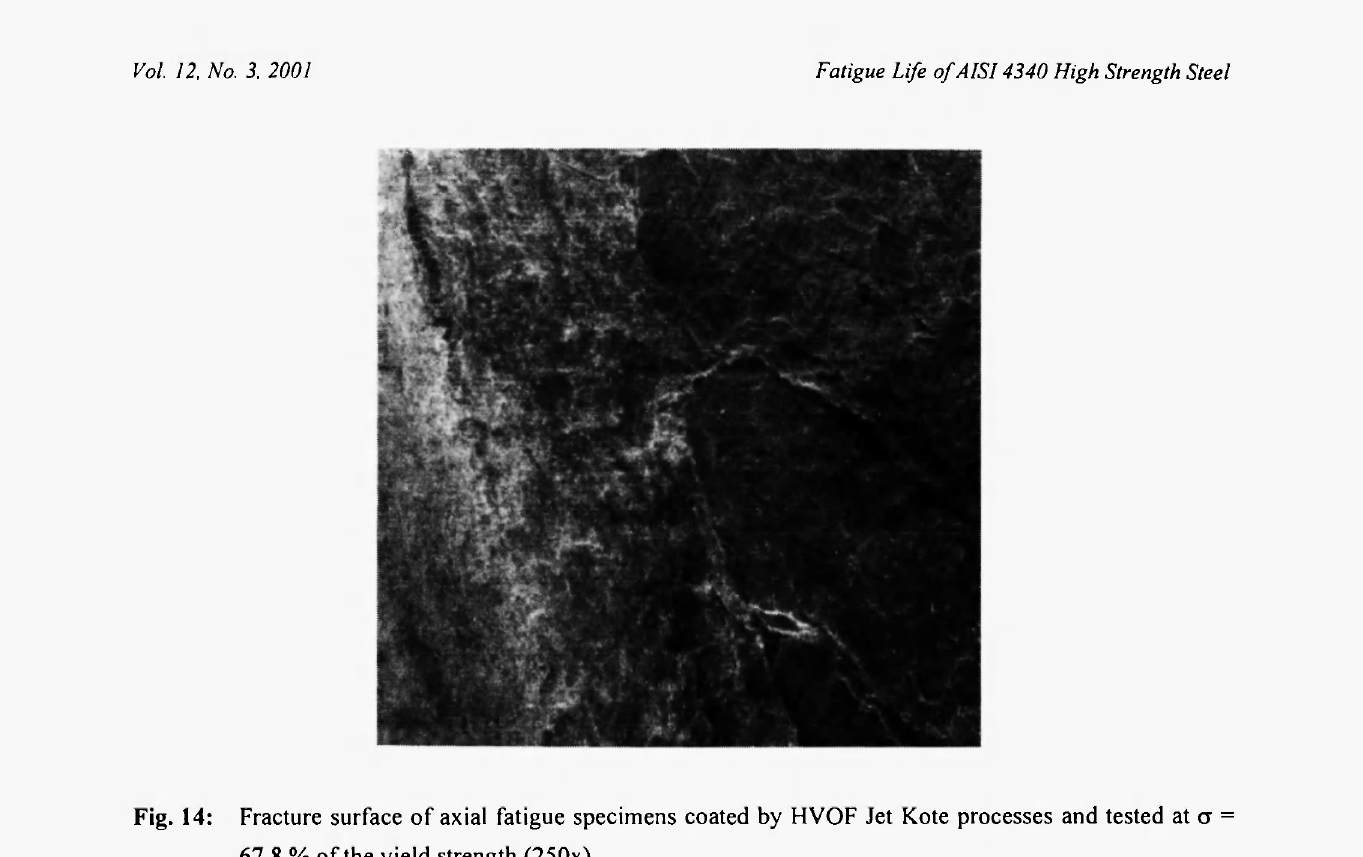
Fig. 14: Fracture surface of axial fatigue specimens coated by HVOF Jet Kote processes and tested at σ = 67.8 % of the yield strength (250x).